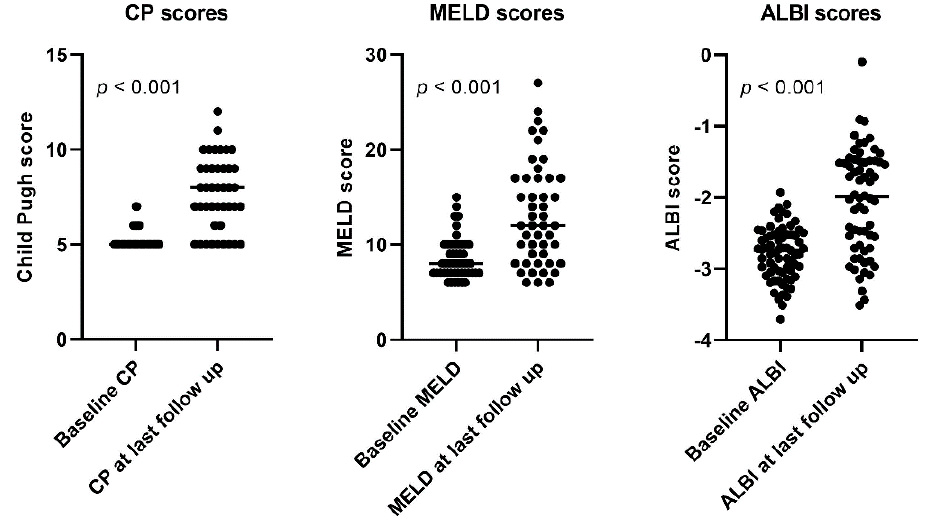
Figure 2. Liver function scores at baseline compared to last follow-up after SIRT in the study cohort. ALBI: albumin-bilirubin; CP: Child Pugh; MELD: model for end-stage liver disease. The presence of liver cirrhosis at the baseline was significantly associated with liver decompensation at the last follow-up after SIRT (odds ratio (OR) of 4.0 (95% CI 1.2–13.2, p = 0.018)) (shown in Table 3). Furthermore, a lower ALBI score at the baseline was also significantly associated with a better outcome, with an OR of 0.074 per point of absolute increase (i.e., more negative ALBI score) (95% CI 0.012–0.475, p = 0.006) (shown in Table 3). After multivariate analysis, the ALBI score remained an independent predictor of liver decompensation at the last follow-up (OR of 0.114 (95% CI 0.016–0.824, p = 0.031)), making it the only predictor that showed a significant correlation with liver decompensation at last